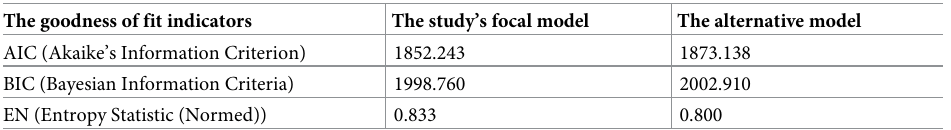
Table 7. Results of BIC, AIC and